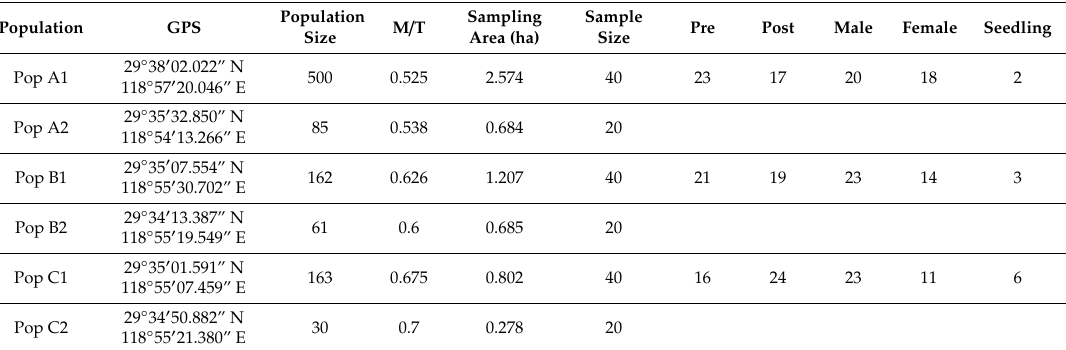
Figure 3. Isolated tree stands on islands in the Thousand-Island Lake of China. Table 1. Population size, sex ratio (male / total), and sample size of each Pistacia chinensis population, as well as the number of pre- and post-fragmentation individuals, number of males, females, and seeding individuals in the northern part of Thousand-Island Lake, China.